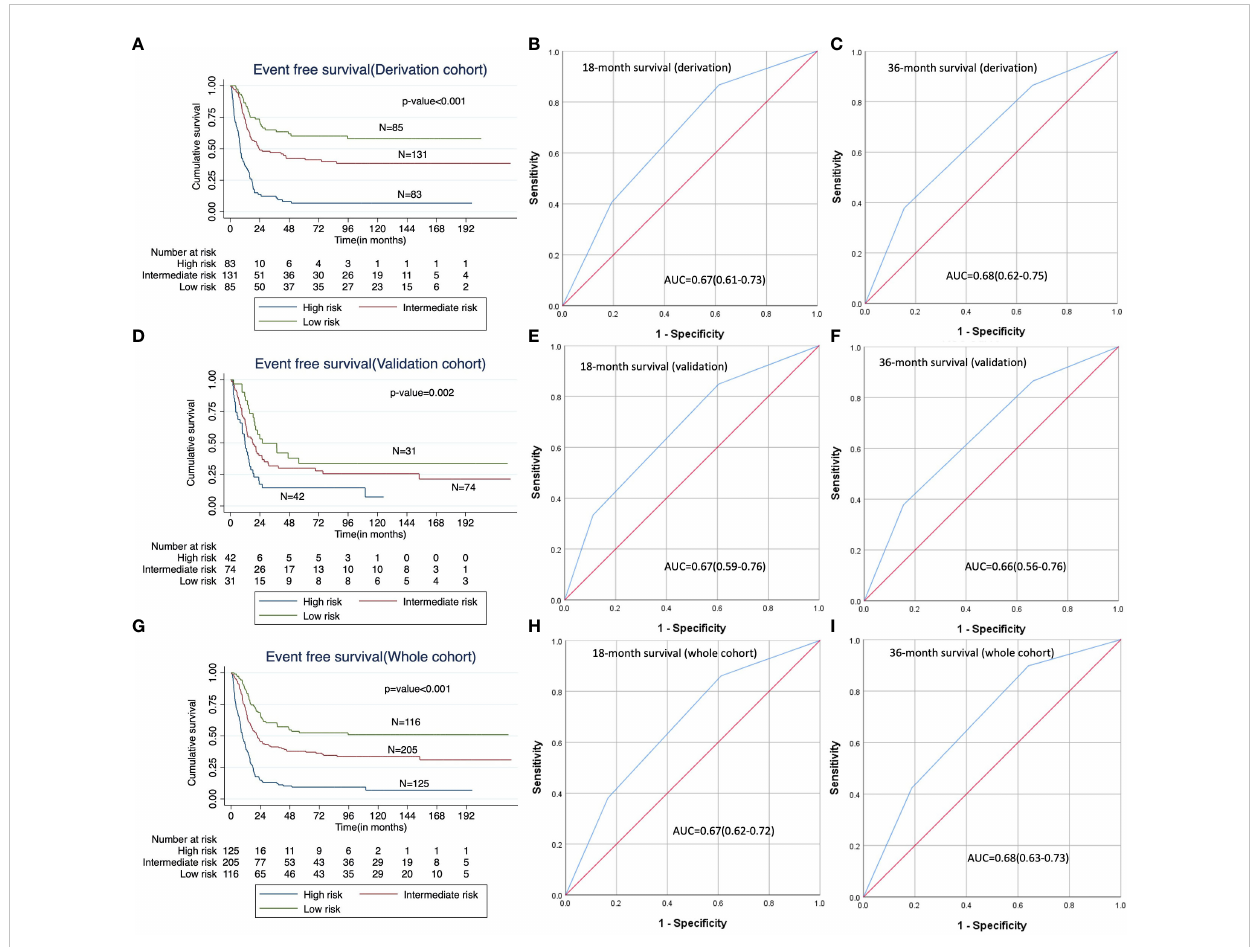
FIGURE 2 Predictive ability of the risk score category; (A, D, G) : Kaplan Meier curves showing impact of risk score category on EFS in the derivation, validation and whole cohorts respectively; (B, E, H) : Receiver operating characteristic (ROC) curves for the risk score categories for 18-month EFS in the derivation, validation and whole cohorts respectively; (C, F, I) : Receiver operating characteristic (ROC) curves for the risk score categories for 36- month EFS in the derivation, validation and whole cohorts